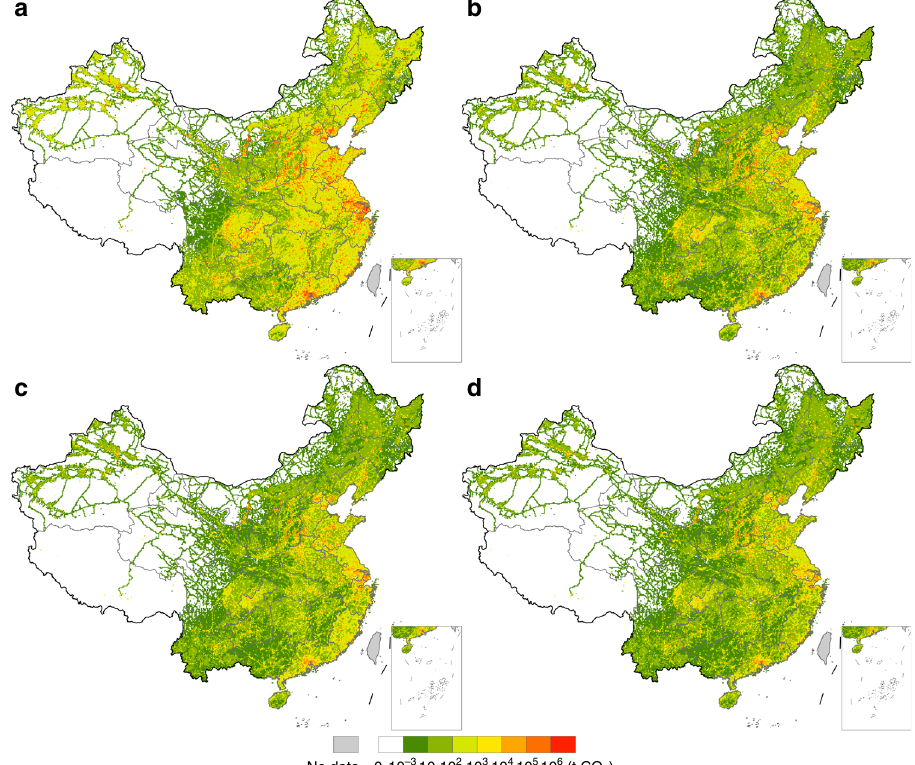
Fig. 1 Carbon footprint hotspots of global and regional consumptions in mainland China in 2012. a shows carbon footprint (CF) hotspots of foreign fi nal consumption. b – d show carbon footprint hotspots of the consumption of the United States, Hong Kong, and Japan, respectively. Among all foreign regions, the United States, Hong Kong, and Japan have the largest CFs in China, contributing ~23.0%, 10.8%, and 9.0%, respectively, to the total foreign CF in China in